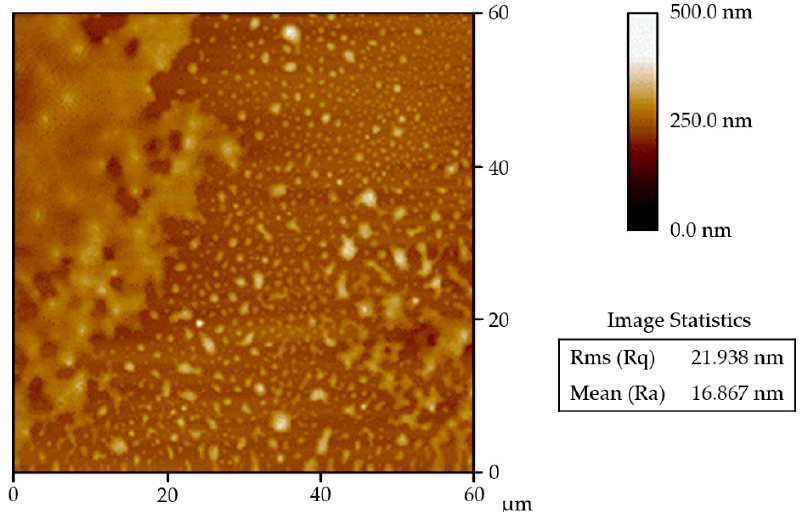
Figure 2. Typical surface topology of FluoroSyl coated on a smooth glass substrate taken with atomic force microscopy. Roughness values are shown for this specific scan.